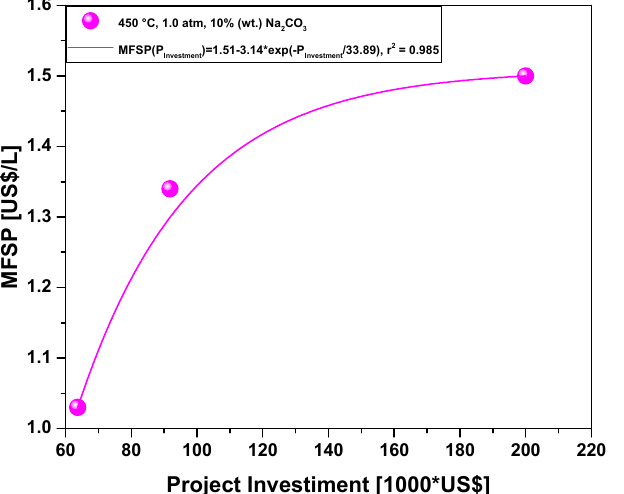
Figure 7. MFSP as a function of cost of lipidic material by sensitivity analysis for a 450 L/day production.